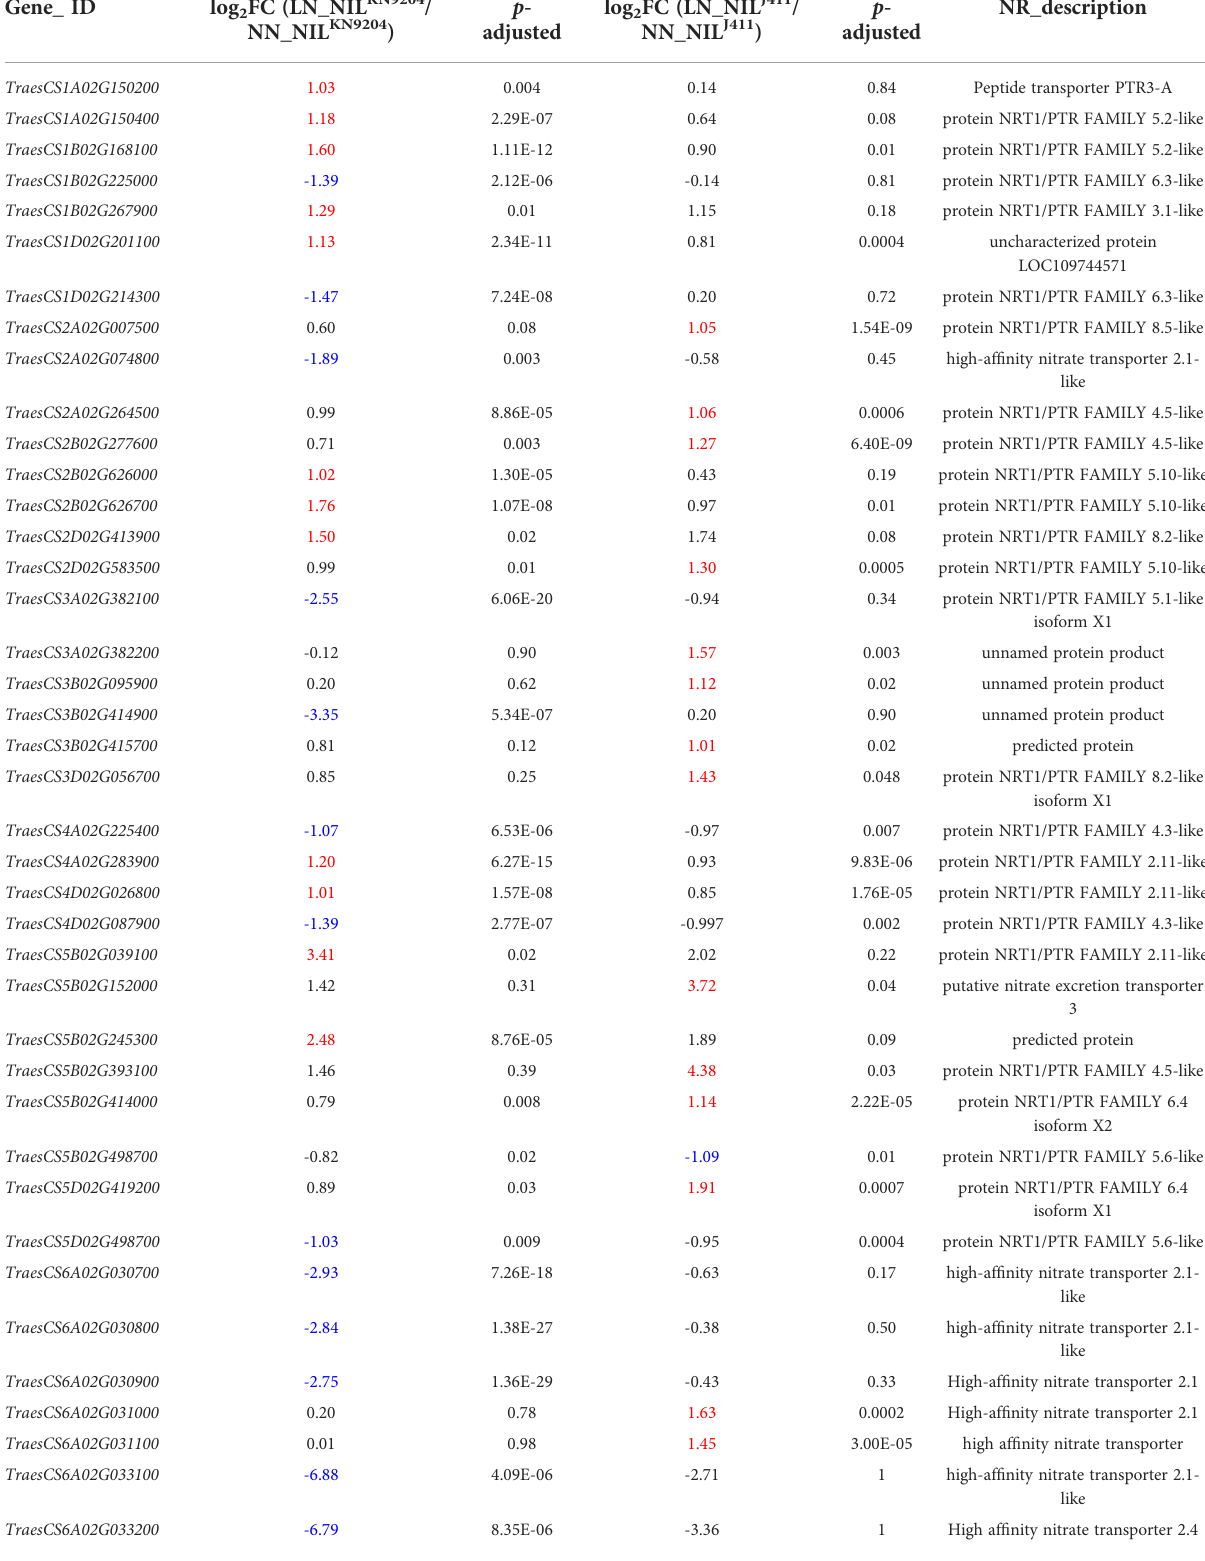
TABLE 2 NRT genes speci fi cally expressed in the NIL KN9204 or NIL J411 in response to